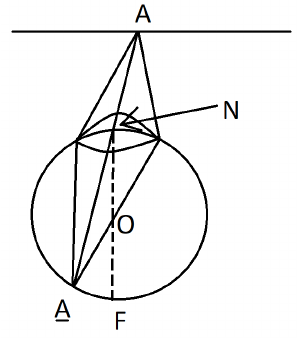
Figure 2. Central